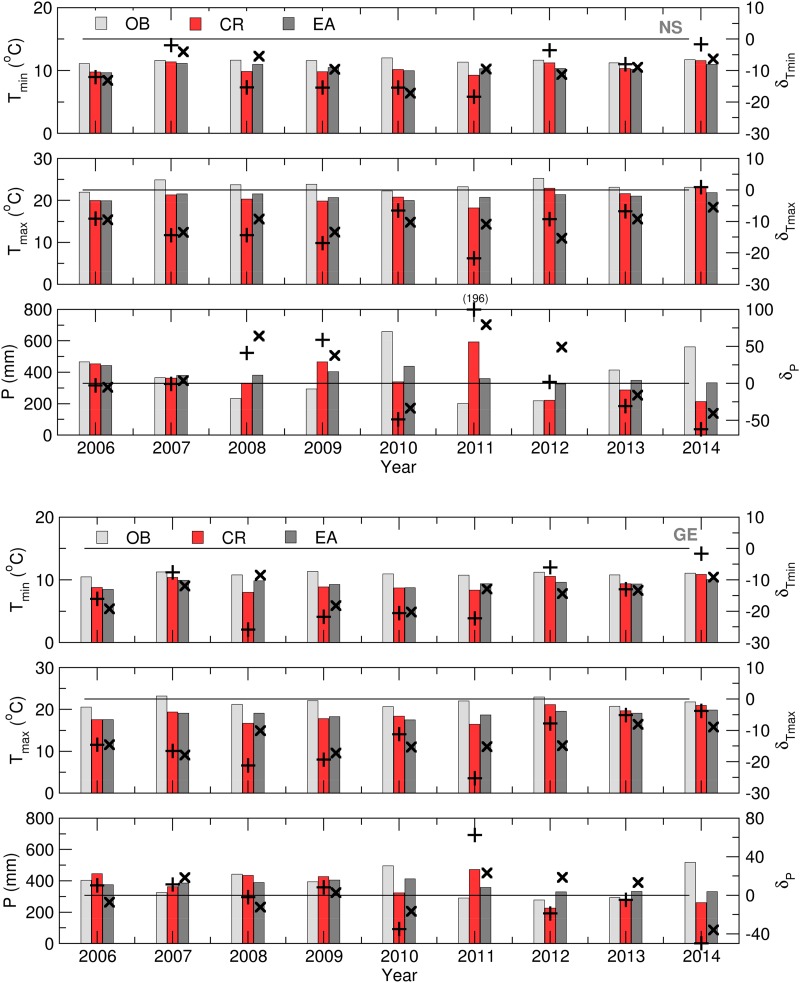
Tmin, Tmax and P for 1 March–31 August: the average values (bars) and relative deviations (‘+’, CR; ‘×’, EA) obtained using the OB, CR and EA datasets for NS (up) and GE (down) for 2006–2014.